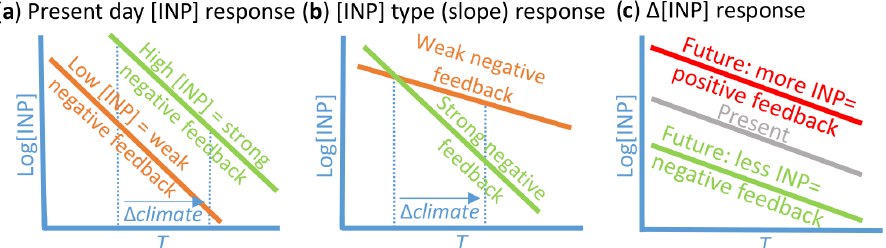
Figure 4. Illustration of how the cloud-phase feedback depends on the concentration and nature of ice-nucleating particles. The strength of the feedback depends on (a) the present-day INP concentration – the cloud phase feedback is more negative with a higher INP concentration since there is a greater potential to replace ice with water on warming (this is mechanistically illustrated in Fig. 3a and b); (b) the type of INP – different INP types have different temperature dependences (dlog[INP] / d T ) and for those with steeper temperature dependencies there is a greater potential to replace ice with liquid; (c) INP concentrations may change in the future – increases or decreases in INP concentration will feedback on climate positively or negatively, respectively (this relates to Fig.